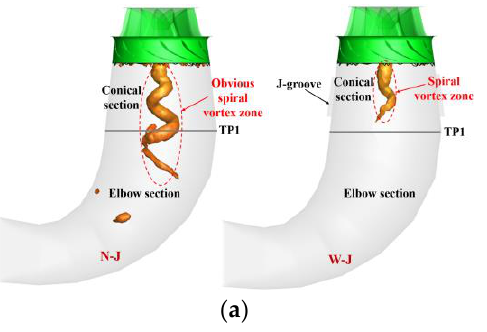
Figure 16. The vortex rope zone with or without J-grooves at Q* = 53% and Q* = 69% operating conditions. ( a ) Q* = 53% (DPL) , ( b ) Q* = 69% DPL).